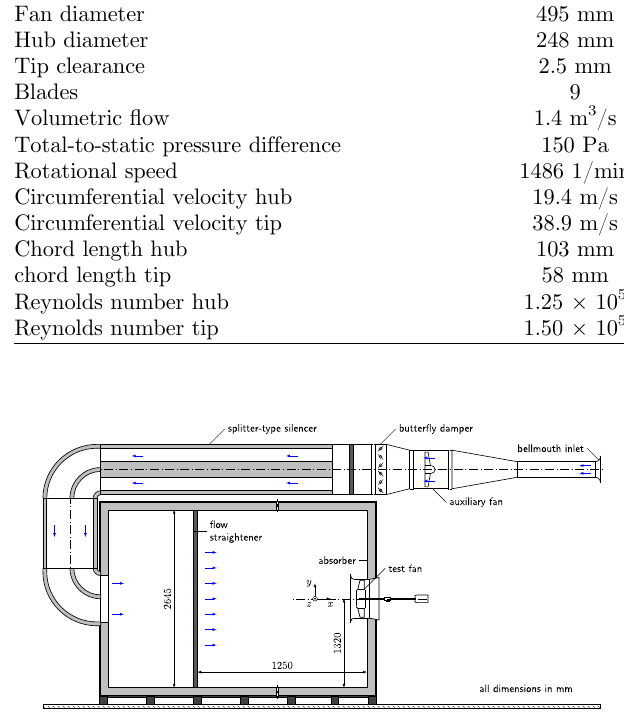
Figure 2. Measurement chamber according to